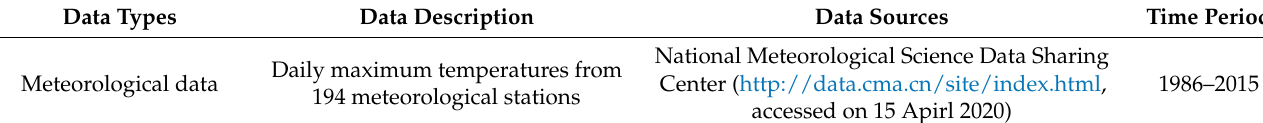
Table 1. Description of the data used for this